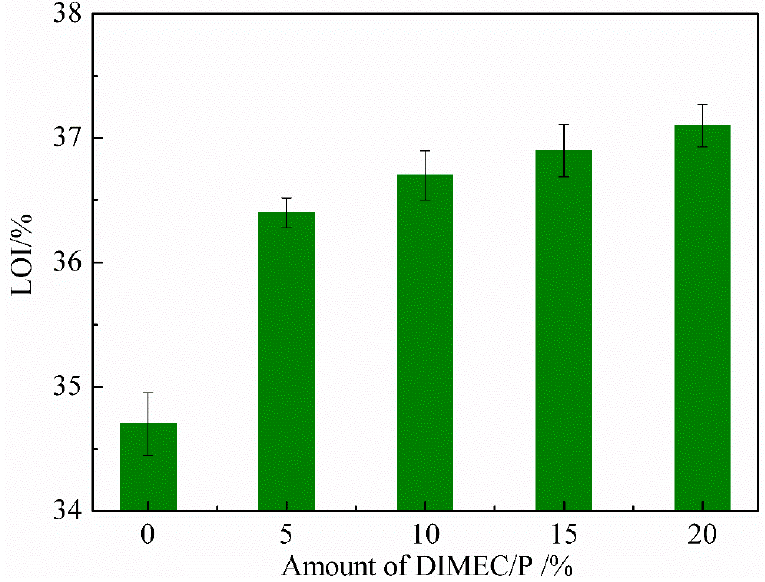
Figure 14. LOI of CPFs.